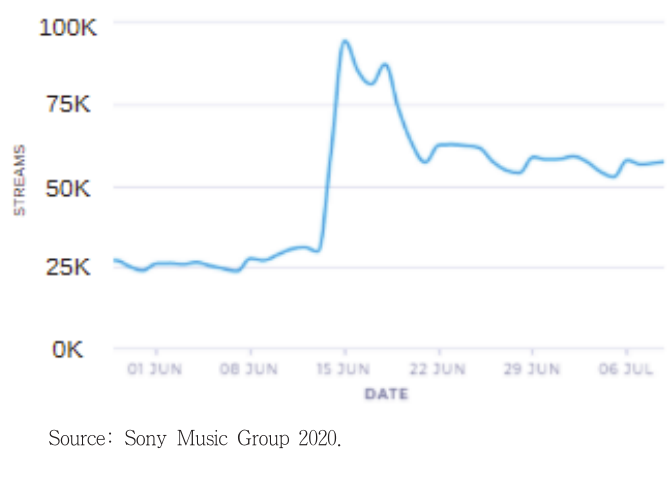
<Figure 4> “Just One Day” audio